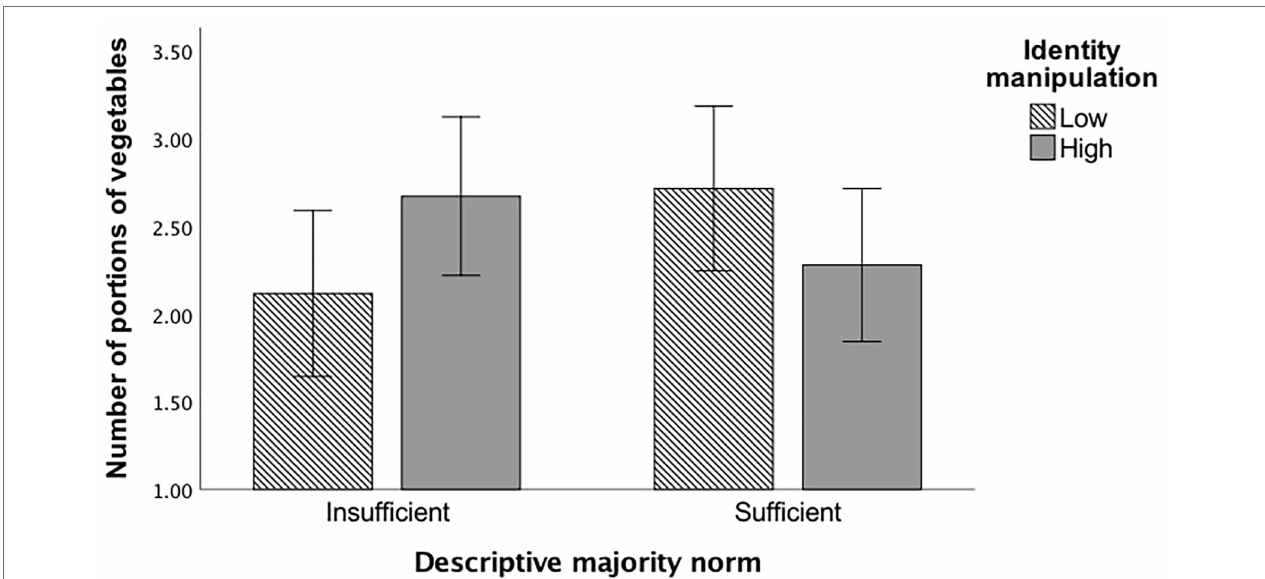
FIGURE 4 | Bar graph illustrating the cross-over interaction of the Norm (“sufficient”/“insufficient”) and Identification (“low”/“high”) manipulations on the number of vegetable portions participants consumed at follow-up. The means are adjusted for attitudes, perceived behavioral control, intentions, and identification as a “sufficient fruit and vegetable eater” as covariates. Error bars represent 95% confidence intervals. ( N =